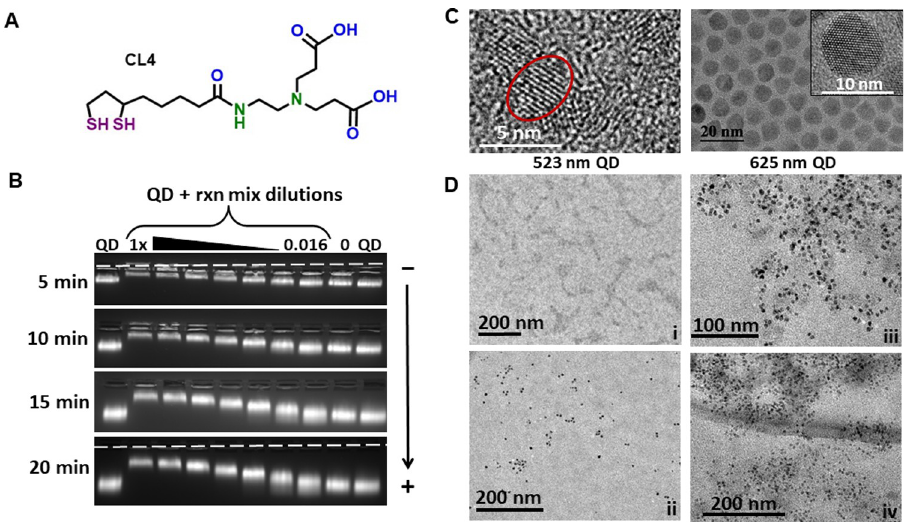
Fig 2. Characterization of PURExpress 1 –QD conjugates. (A) Chemical structure of the CL4 ligand used to make the QDs colloidally stable in aqueous shown in the open dithiol configuration. (B) Agarose gel electrophoretic mobility shift assay of 523 nm emitting CdSe/CdS/ZnS core/shell/shell QDs incubated without and with a series of decreasing concentrations of the PURExpress 1 protein solution. Less mobility is correlated with binding to enzyme and the magnitude of this is decreased as the protein solution is serially diluted. The dashed white line indicates the location of sample wells in the gel. (C) Left—High-resolution TEM micrograph of the 523 nm emitting CdSe/CdS/ZnS core/shell/ shell QDs with an average diameter of 4.1 ± 0.5 nm. A single QD is circled in red for visualization. Right—High- resolution TEM micrograph of the 625 nm emitting CdSe/ZnS core/shell QDs utilized for nanoaggregation studies due to their larger size and higher electron density which makes for easier imaging. (D) TEM micrographs of the PURExpress 1 protein solution (i), 625 QDs in buffer (ii), and 625 QD mixed with 0.5 × PURExpress 1 solution at two different magnifications (iii, iv). Only when the QDs are mixed with the PURExpress 1 solution is clustering seen. The grey shading around the QD clusters in (iii, iv) are believed to be the PURExpress 1